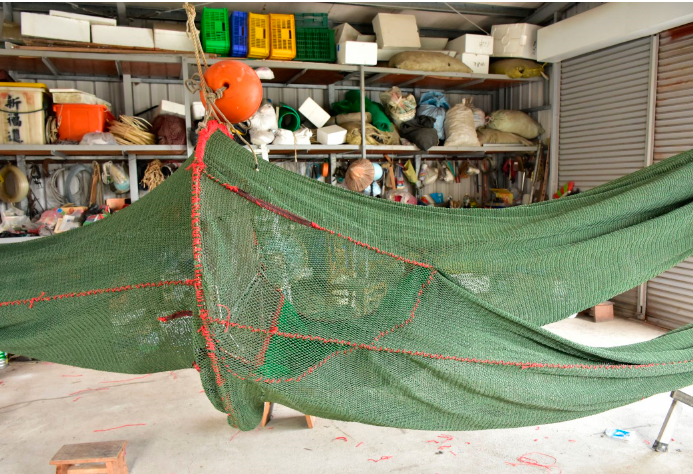
Figure 5. Bottom trawl and attached cover net (the upper right net is the cover net, and the bottom right net is the codend) in the experimental vessel. The photograph was taken in Kaohsiung.